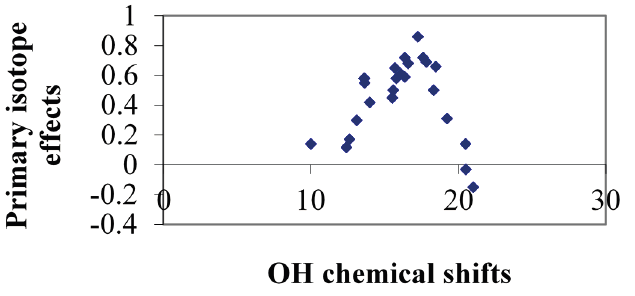
Figure 17. Plot of primary isotope effects vs. OH chemical shifts for symmetrical systems based on data from Refs.